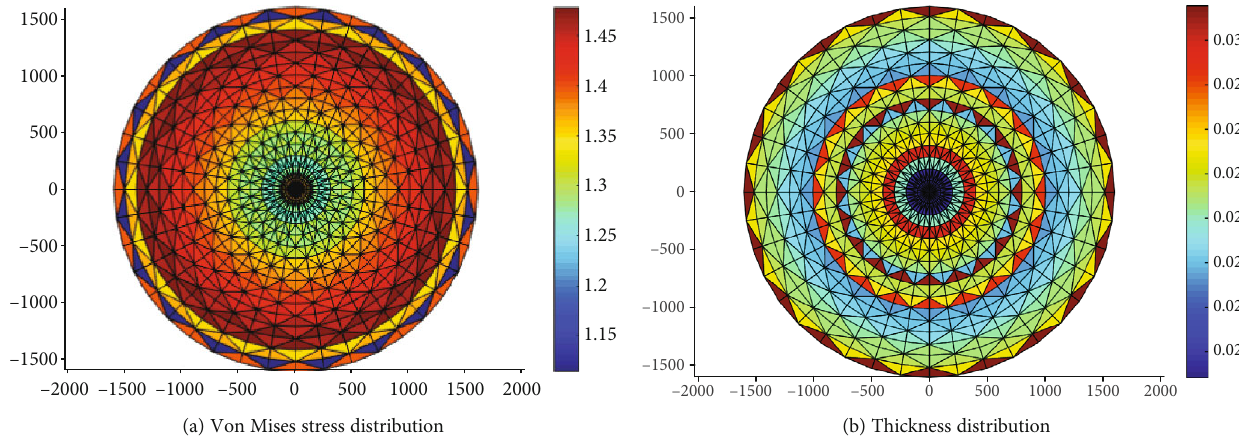
Figure 4: Stress and thickness distribution of optimal re fl ector by the BFP-E Method.